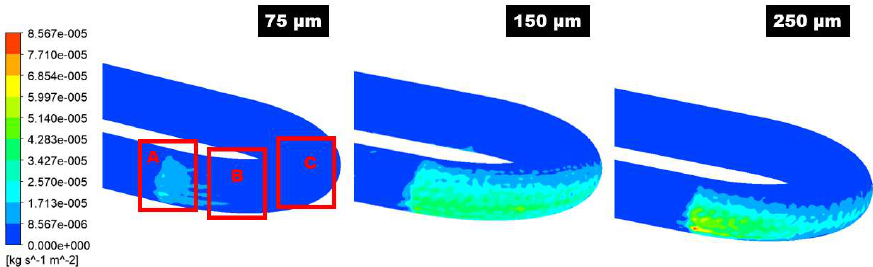
Figure 11. The contour of the erosion distribution in the 180° U−bend elbow under three different particle sizes.